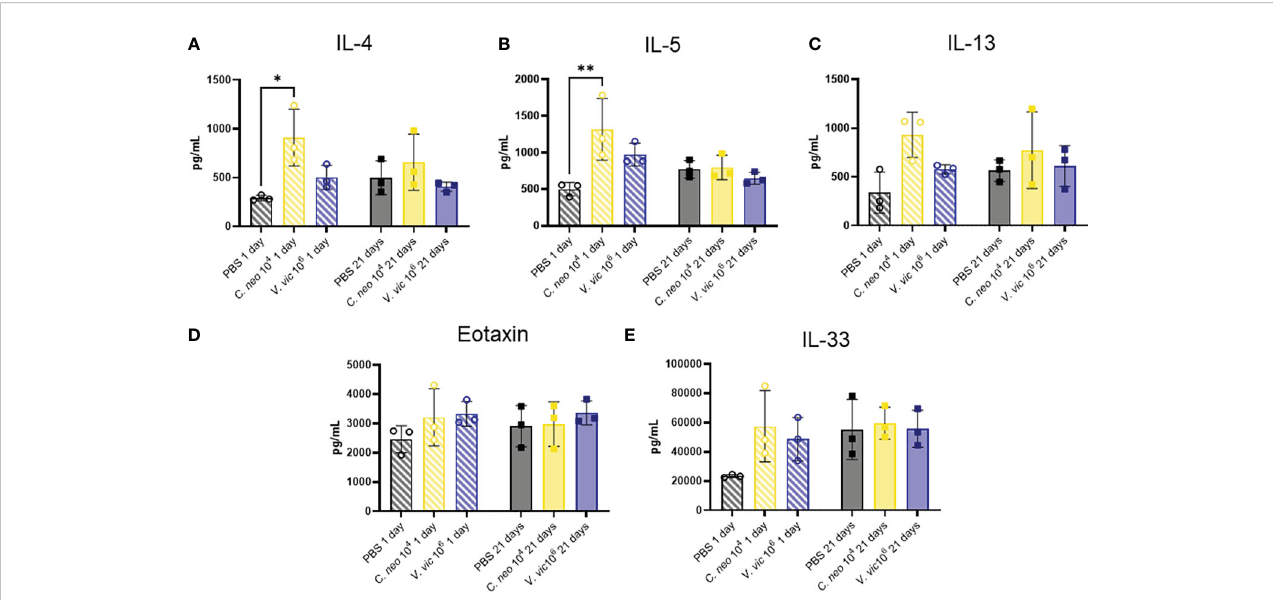
FIGURE 7 C. neoformans increases IL-4 and IL-5 in lung one day following repeated exposure. Cytokine concentrations in lung homogenate were determined via Luminex after repeated exposure to PBS (black), 10 4 C. neoformans cells (yellow) or 10 6 V. victoriae cells (blue) at 1 day post fi nal exposure (circles, crossed bars, left) or 21 days post fi nal exposure (squares, solid bars, right). (A) IL-4, (B) IL-5, (C) IL-13, (D) Eotaxin (CCL11), and (E) IL-33. n=3 per group, *P < 0.05, **P < 0.01. P values were determined by ordinary one-way ANOVA with Tukey ’ s multiple comparisons test comparing each exposure together for the same